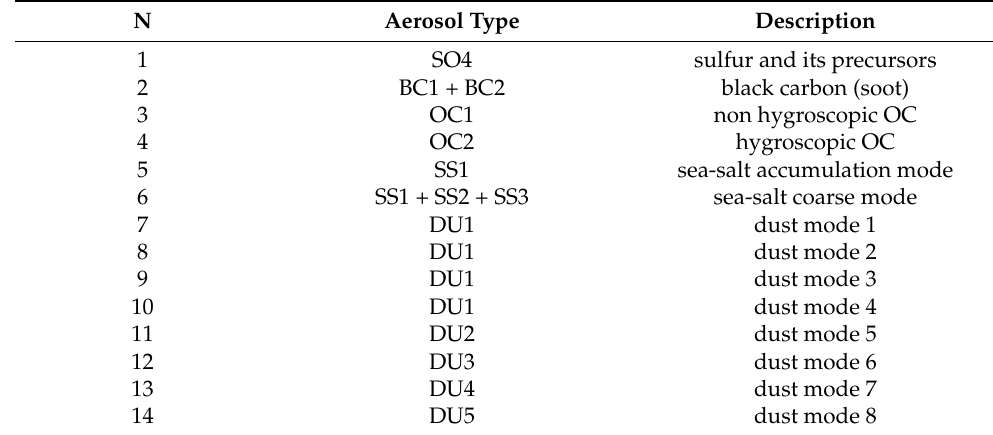
Table 3. Aerosol species defined by Godard coupling strategy. N Aerosol Type